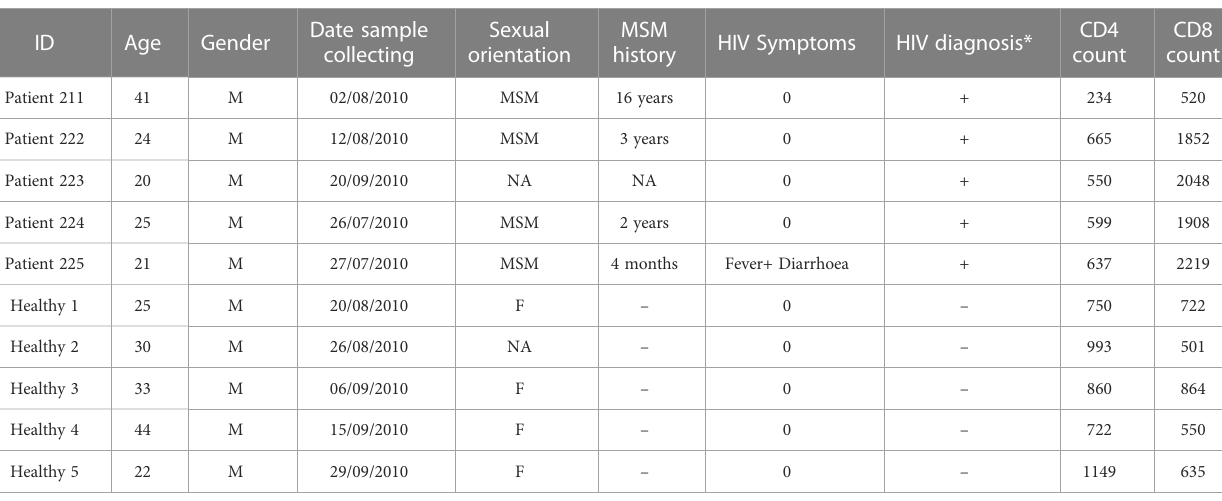
TABLE 1 Brief clinical